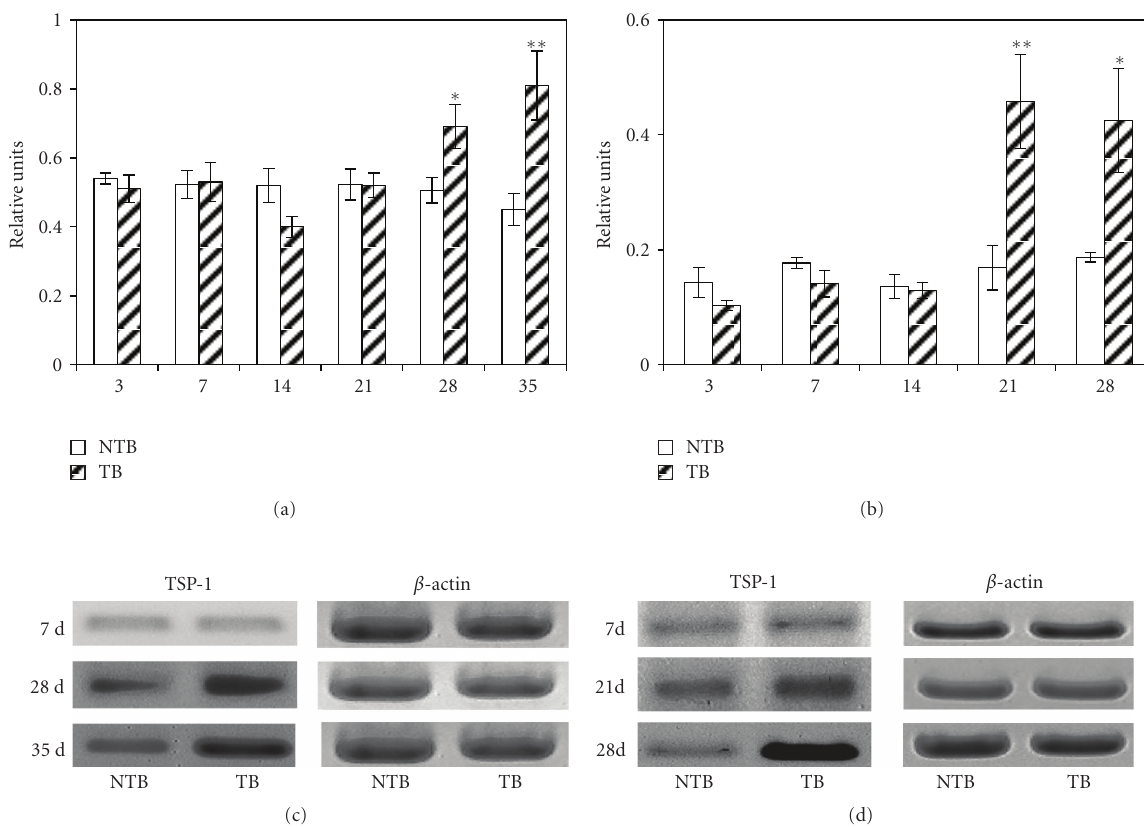
Figure 3: Hepatoma growth increases TSP-1 mRNA expression in peritoneal macrophages (a) and thymocytes (b). Total RNA was isolated from peritoneal cells or thymocytes from each mouse individually. Two μ g of total RNA were used to perform semiquantitative (reverse- transcription) RT-PCR as described; mRNA levels specific for TSP-1 were normalized to β -actin. Each bar represents the average obtained from 8 mice (M ± SEM); ∗ P < . 05, ∗∗ P < . 01 compared to control. (c) Representative RT-PCR analysis for TSP-1 mRNA expression in macrophages. (d) Representative RT-PCR analysis for TSP-1 mRNA expression in thymocytes. Thymocytes on the 35 day were not studied because of the thymic involution. NTB: nontumor bearing mice; TB: mice with hepatoma 22a. Table 2: Rate of tumor growth per